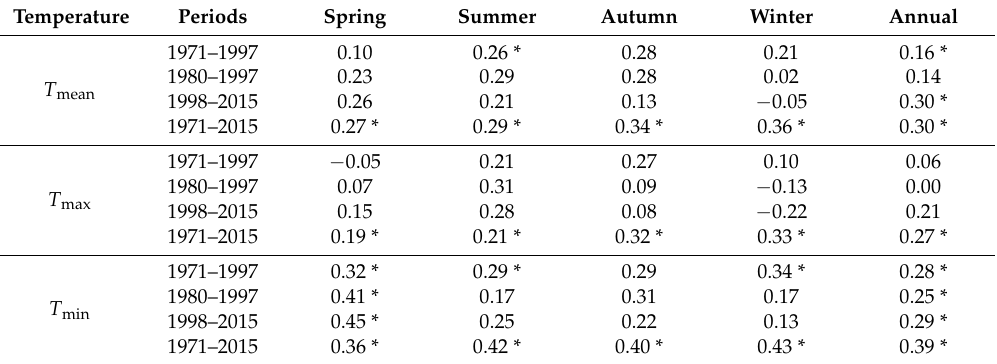
Table 2. The warming trends ( ◦ C decade − 1 ) of the mean temperature ( T mean ), the maximum temperature ( T max ) and the minimum temperature ( T min ) on annual and seasonal scale in different periods. Temperature Periods Spring Summer